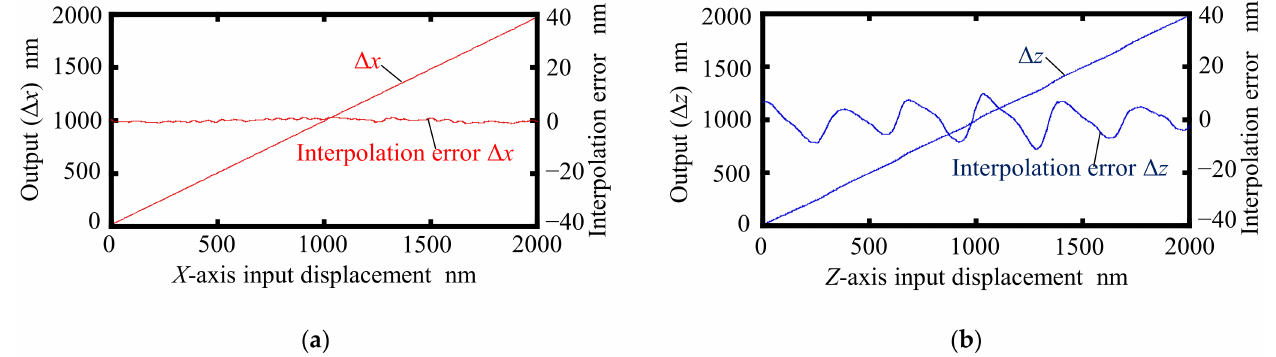
Figure 7. Interpolation errors: ( a ) Interpolation error in measurement of ∆ x ; ( b ) interpolation error in measurement of ∆ z .